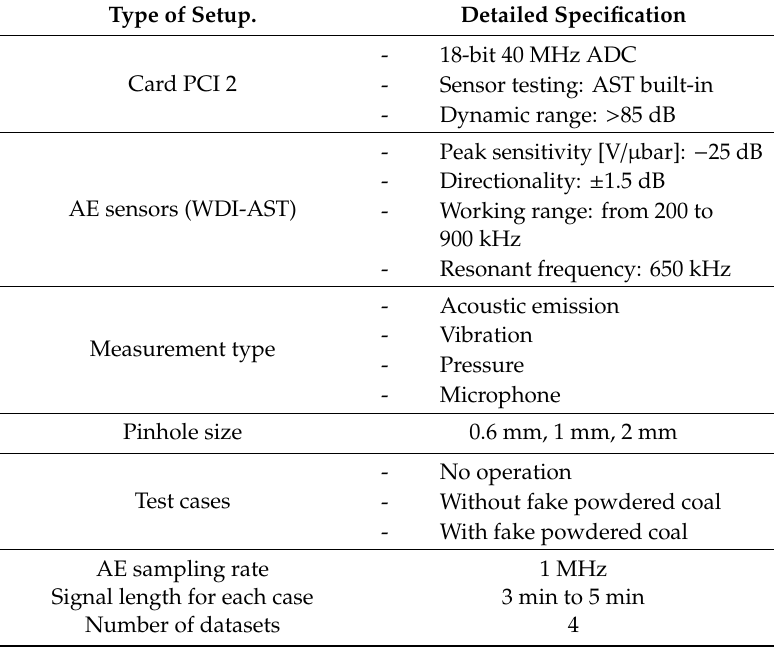
Figure 2. Detailed setup of the data acquisition system. Table 1. Data acquisition system and data specification.